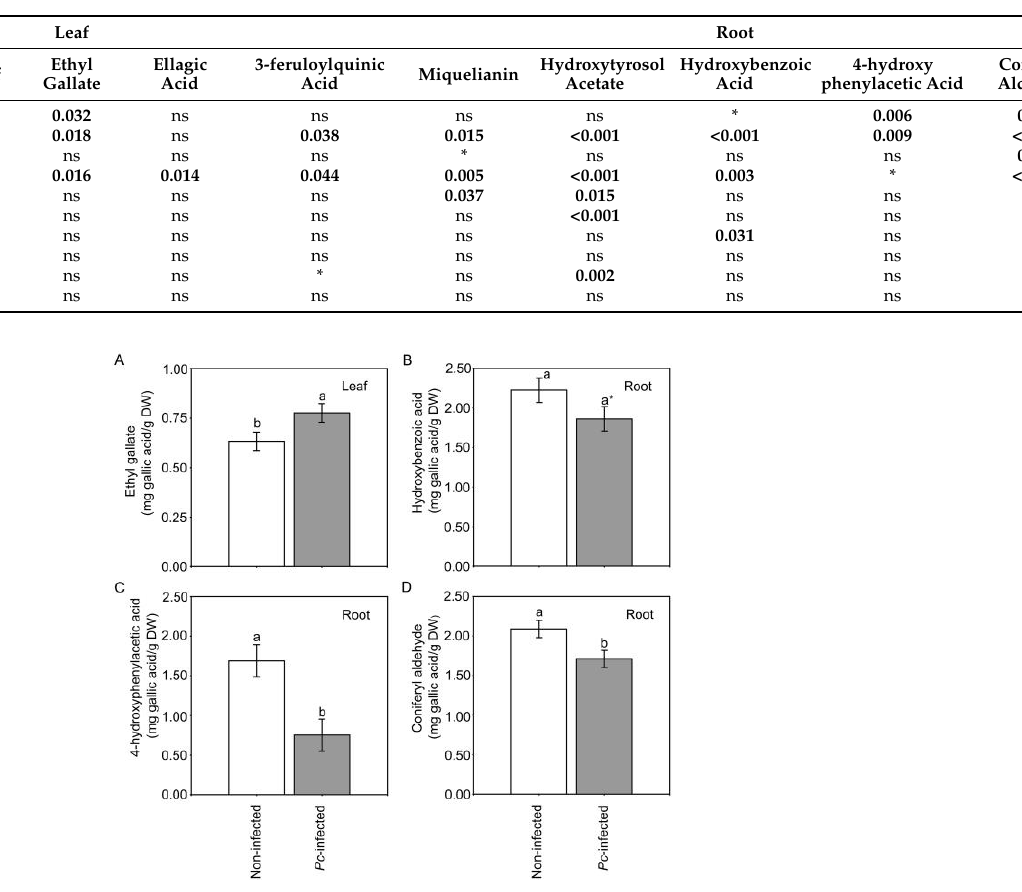
Table 4. Results of general linear models for analyses of chemical changes in seedlings of two Castanea sativa mother trees in response to warming scenarios and Phytophthora cinnamomi infection. Significant p -values are indicated in bold ( p < 0.05), asterisks indicate marginally significant differences ( p < 0.10), and ns indicates non-significant result.